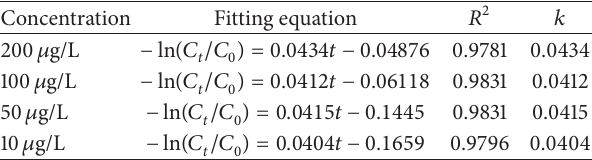
Table 1: Kinetic model for TCNM